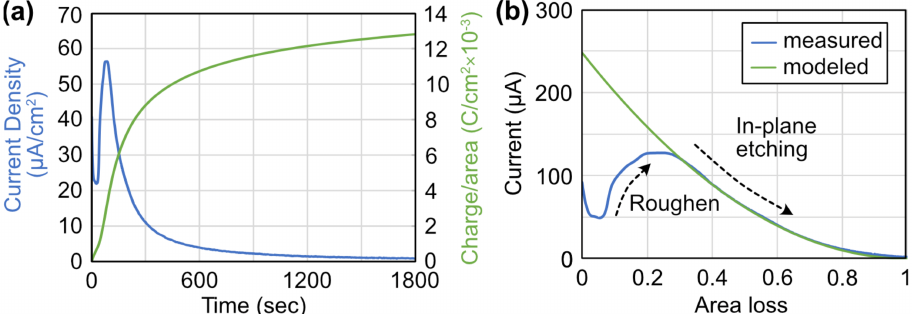
Figure 8. Plot of ( a ) current density and charge density versus time for an 8 nm thick InGaN layer at a potential of 0.4 V. The charge density is used to calculate the amount of InGaN volume etched over time. Plot of ( b ) measured and modeled current versus InGaN area loss at 0.4 V. At the initial stages of etching, the current increases due to surface roughening. The current can be modeled at higher area loss with a modified photoconductivity